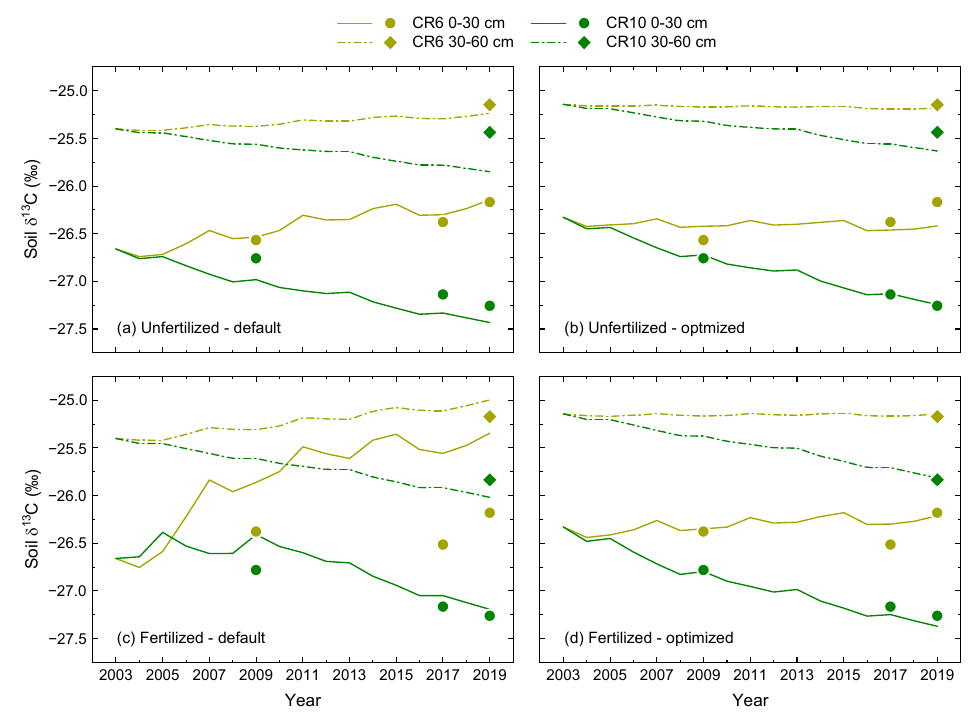
Figure 3. Temporal dynamics of measured (symbols) and modelled δ 13 C (lines) in two different soil layers of CR6 (50% maize) and CR10 (no maize) after the start of the experiment in 2004. ( a , c ): Simulations with pre-defined model parameters; ( b , d ): Simulations after parameter optimization. Fertilized treatments received biogas digestate. The data points represent averages of four measured δ 13 C values sampled during the dormant period after the respective cropping season.